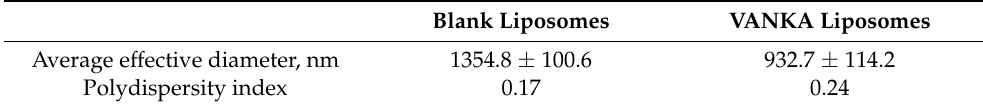
Table 2. Size and polydispersity index of